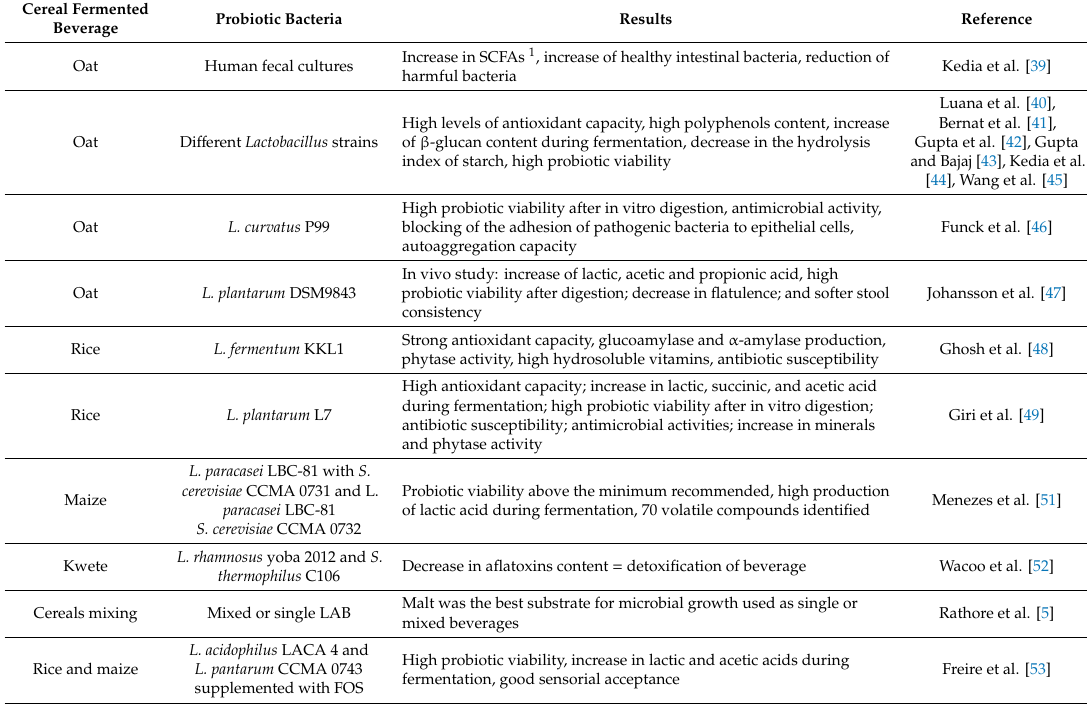
1 SCFAs: short chain fatty